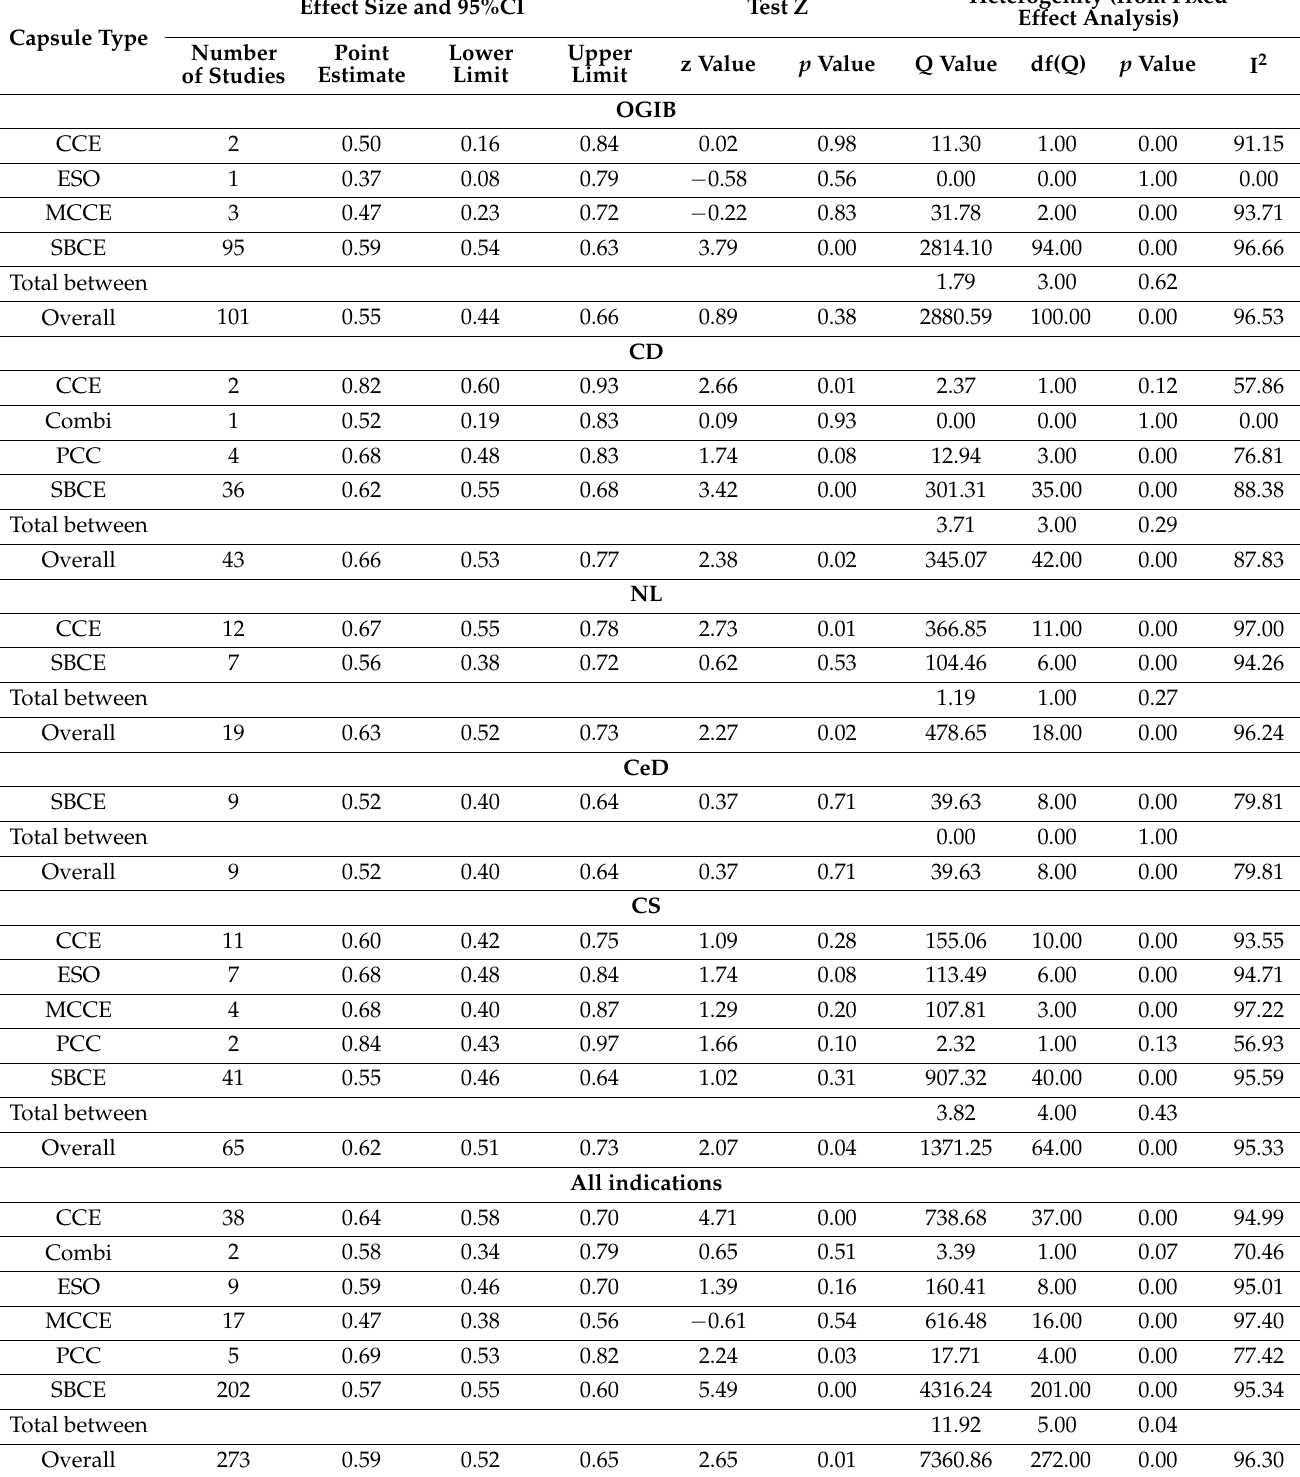
Table 1. Detection rates by type of capsule